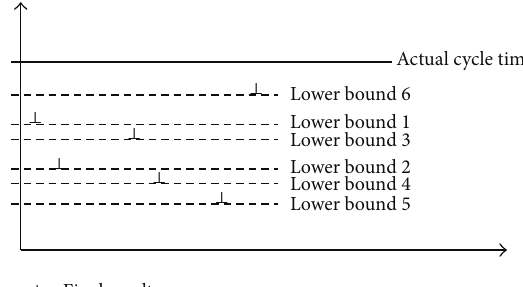
Figure 4: Iterative reduction of the lower